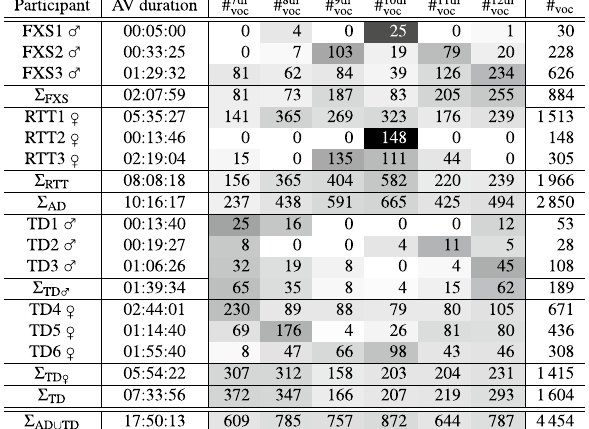
Table 1. Available audio-video (AV) duration in format hh:mm:ss (two-digit hour number:two-digit minute number:two-digit second number; seconds rounded down to integer values; sums calculated on the basis of exact durations) as well as month-wise ( # 7th, 8th, 9th, 10th, 11th, 12th voc ) and overall ( # voc ) number of included vocalisations per participant, per group, and in total. AD, atypical development; FXS, fragile X syndrome; RTT, Rett syndrome; TD, typical development; ♀ , female; ♂ , male; colour code for month-wise numbers of vocalisations: greyscale proportional to the total number of vocalisations per line between white = 0 % of vocalisations and black = 100 % of